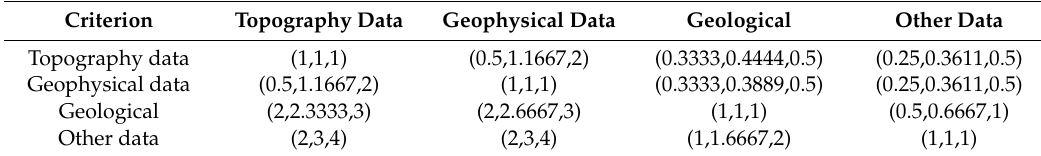
Table 5. Fuzzy evaluation matrix with respect to criteria.